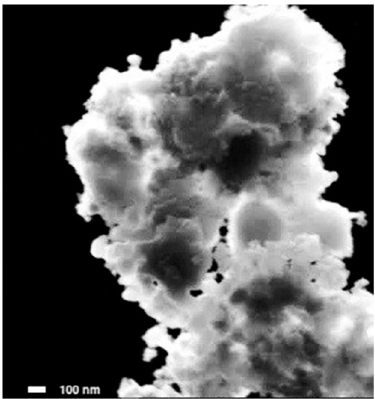
Figure 1. Scanning electron micrographs of CoFeRu at 43,000×.